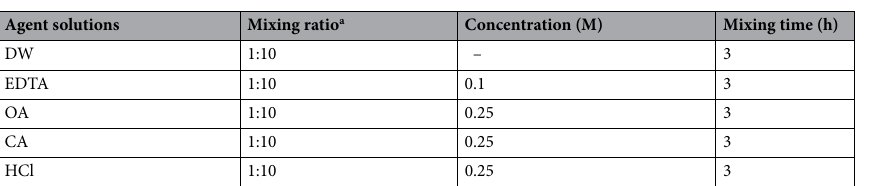
Table 1. Experimental conditions for the treatment of incineration ash with various agents for heavy metal removal. a Mixing ratio of paper sludge ash to solution.